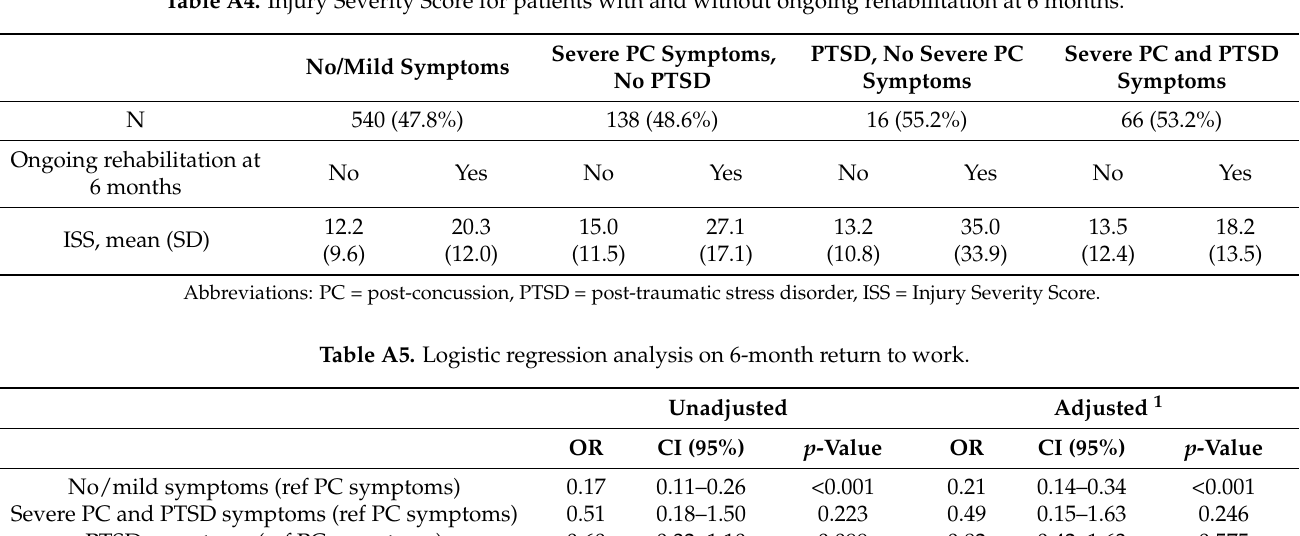
Table A4. Injury Severity Score for patients with and without ongoing rehabilitation at 6 months.